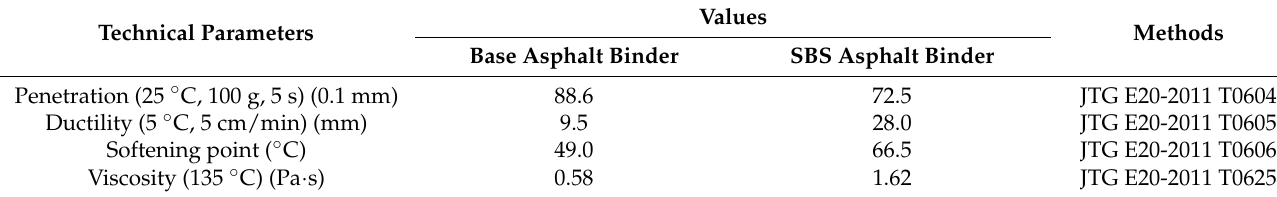
Table 1. Basic properties of asphalt binders.